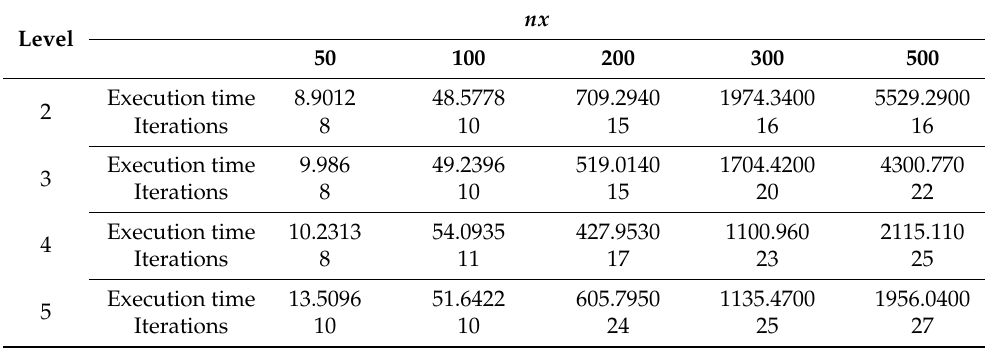
Table 6. Convergence behavior and performance of V cycle of AGAMG in combination with deflation technique and MGenFAspI with droptol = 0 and l fill = 2 for 3D Poisson model problem.